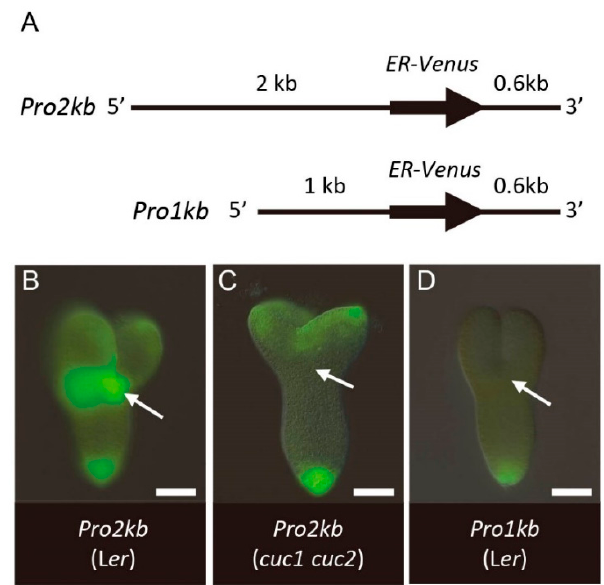
Figure 6. KLU expression is regulated by CUC1 and CUC2 via a specific promoter region. ( A ) Schematic diagram of the KLU reporter genes. ( B – D ) Expression of KLU reporter genes in embryos. Pro2kb in wild type L er ( B ), Pro2kb in cuc1 ‐ 1 cuc2 ‐ 1 ( C ), and Pro1kb in wild type L er ( D ). Arrows indicate the position of the cotyledon boundary region of wild type ( B , D ) and the corresponding region of cuc1 ‐ 1 cuc2 ‐ 1 ( C ). Scale bar, 50 μ m.